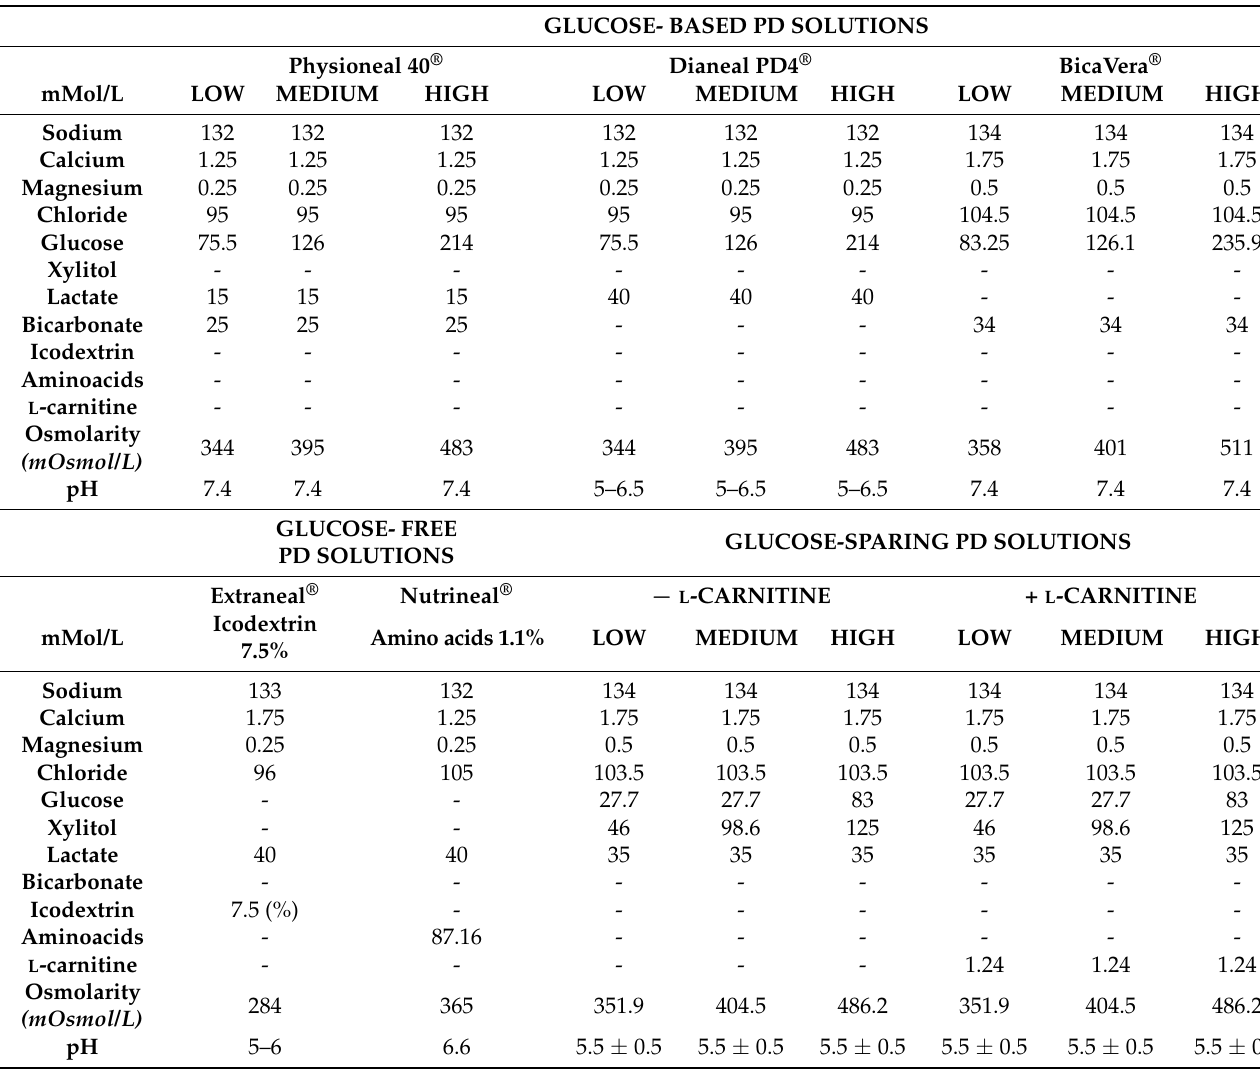
Table 1. Composition of PD